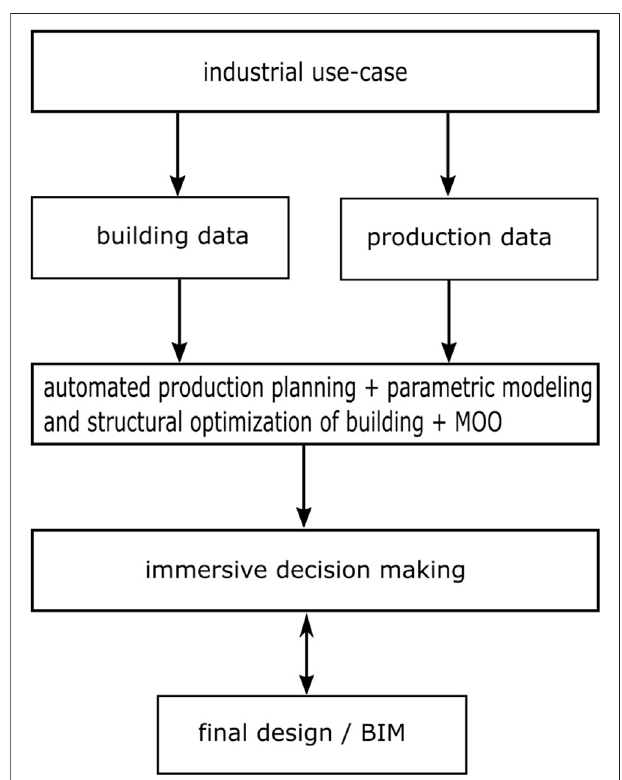
FIGURE1| Conceptual work fl owofdesigningan industrial buildingwith integrated production planning in BIMFlexi. Abbreviations: MOO, multi- objective